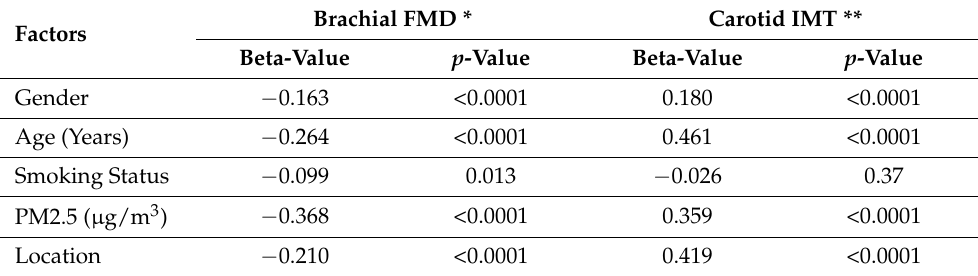
Table 8. Determinants of risk factors for brachial FMD and carotid IMT in 1263 Chinese. Factors